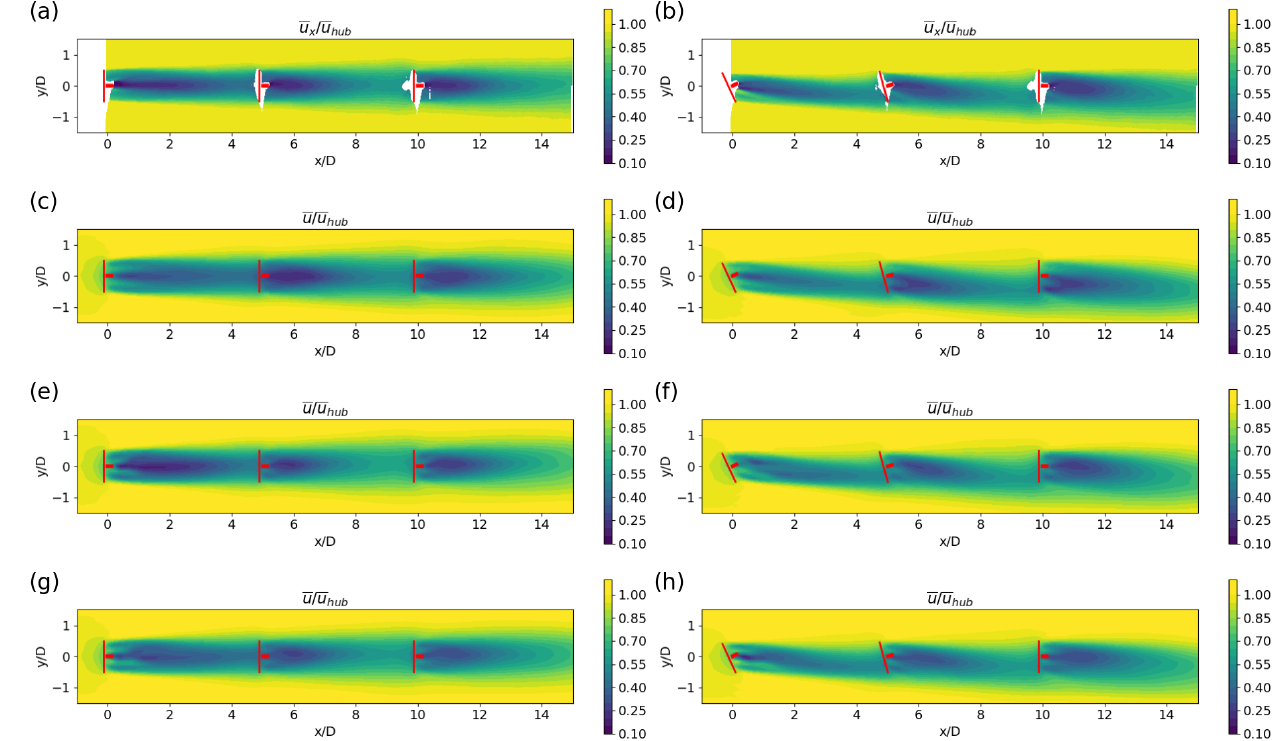
Figure 4. Contours of the normalised streamwise mean velocity u/u hub in the x − y plane at hub height obtained from the wind-tunnel experiments and LES using the ADM-std, ADM-BE and ALM. The lateral offset of the turbines is zero (Cases 1 and 2). (a) Experiment, γ = (0 , 0 , 0 ◦ ); (b) experiment, γ = (25 , 15 , 0 ◦ ); (c) the ADM-std, γ = (0 , 0 , 0 ◦ ); (d) the ADM-std, γ = (25 , 15 , 0 ◦ ); (e) the ADM-BE, γ = (0 , 0 , 0 ◦ ); (f) the ADM-BE, γ = (25 , 15 , 0 ◦ ); (g) the ALM, γ = (0 , 0 , 0 ◦ ); (h) the ALM, γ = (25 , 15 , 0 ◦